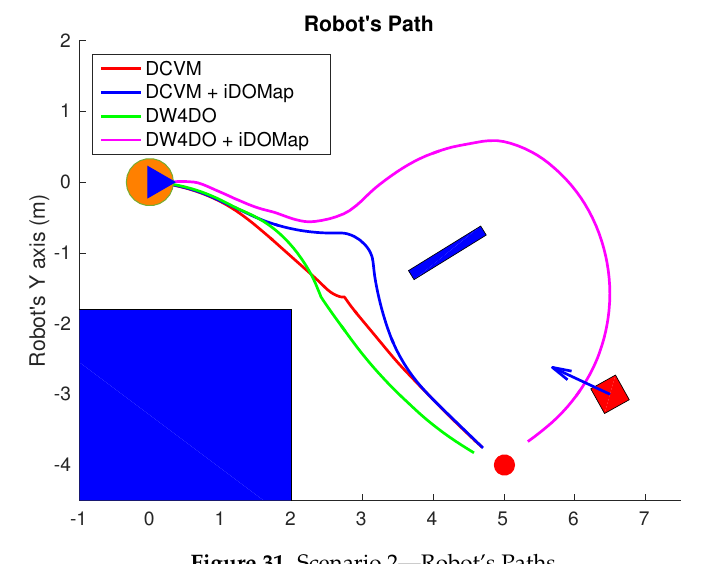
Figure 30. Scenario 2—Robot Paths and iDOMap Detections.